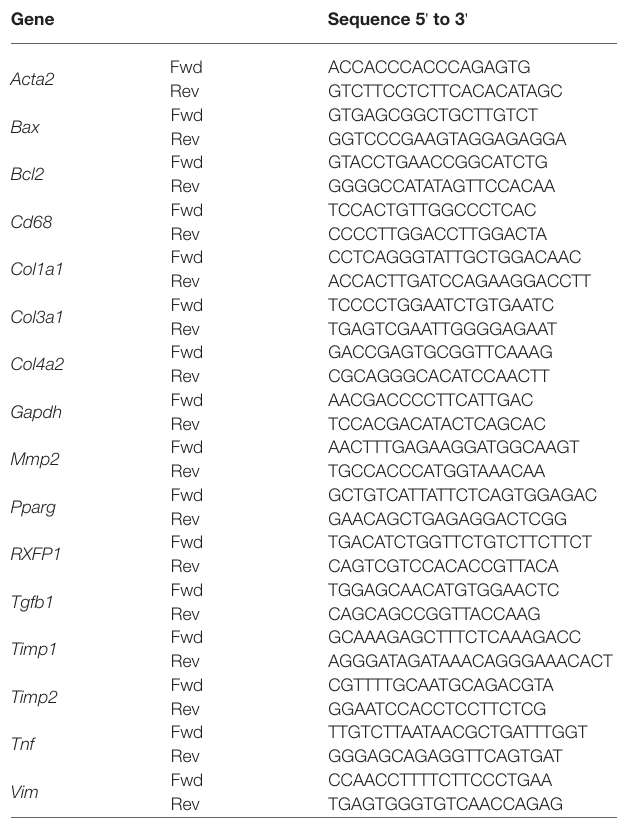
TABLE 1 | Gene sequences of primers used for quantitative real-time PCR